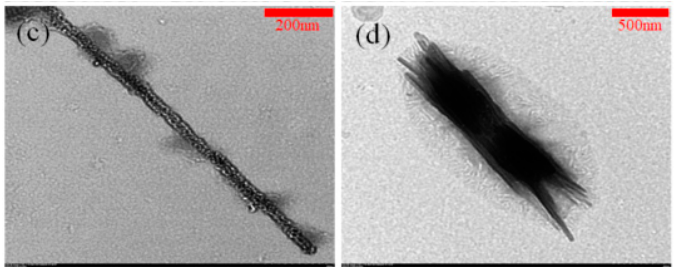
Figure 6. ( a ) Energy dispersive X-ray spectroscopy (EDS) of the SnO nanowires oxidized at 500 °C for 4 h; ( b ) XRD patterns of SnO nanowires on cluster oxidized at 500 °C for 4 h; ( c ) Transmission Electron